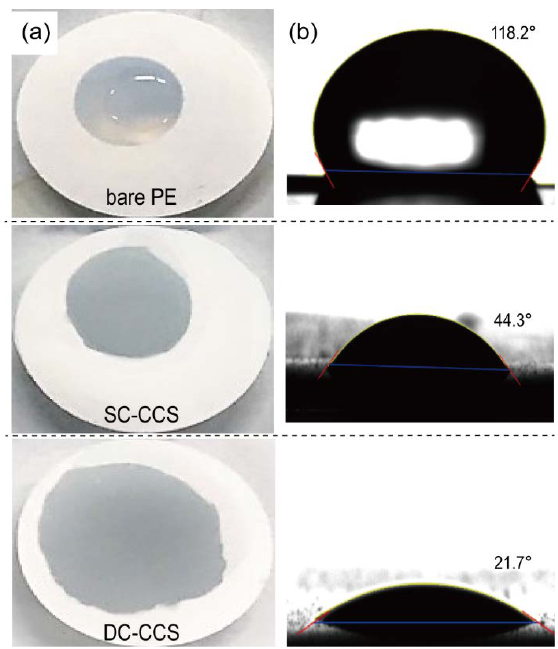
Figure 5. ( a ) Digital camera images of bare PE, SC-CCSs, and DC-CCSs surfaces 5 min after pouring a drop of liquid electrolyte. ( b ) Contact angle images of bare PE, SC-CCSs, and DC-CCSs surfaces 5 min after pouring a drop of D.I. water (separator radius = 1.6 cm). Table 2. Physical properties of bare PE, SC-CCSs, and DC-CCSs.